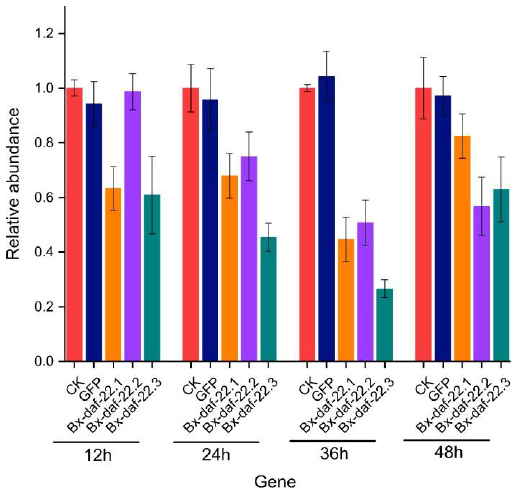
Figure 4. Expression levels of the Bx-daf-22 genes at different times after soaking with the dsRNA of three genes simultaneously for 12, 24, 36, and 48 h. CK: the positive control, nematodes treated with M9 buffer alone; GFP: the negative control, nematodes treated with dsRNA of gfp ; Bx-daf-22.1 : nematodes treated with dsRNA of Bx-daf-22.1 ; Bx-daf-22.2 : nematodes treated with dsRNA of Bx-daf-22.2 ; Bx-daf-22.3 : nematodes treated with dsRNA of Bx-daf-22.3 .